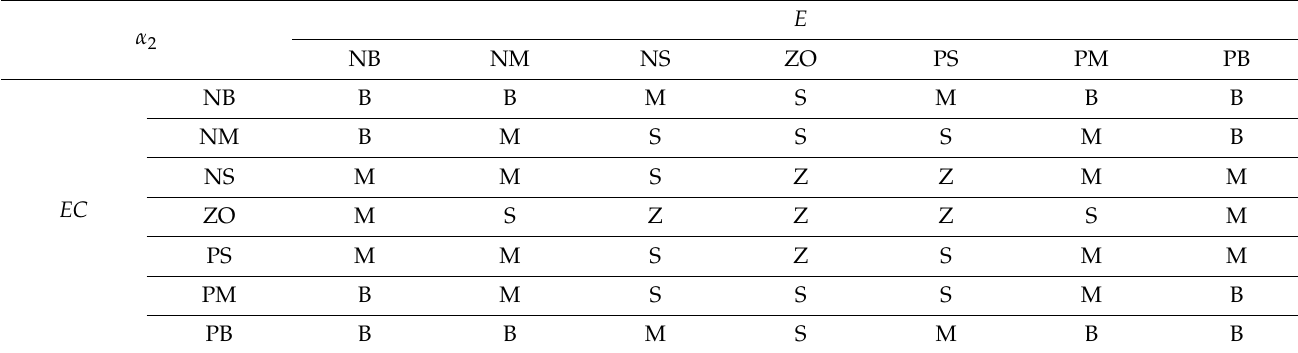
Table 4. Fuzzy rule base for